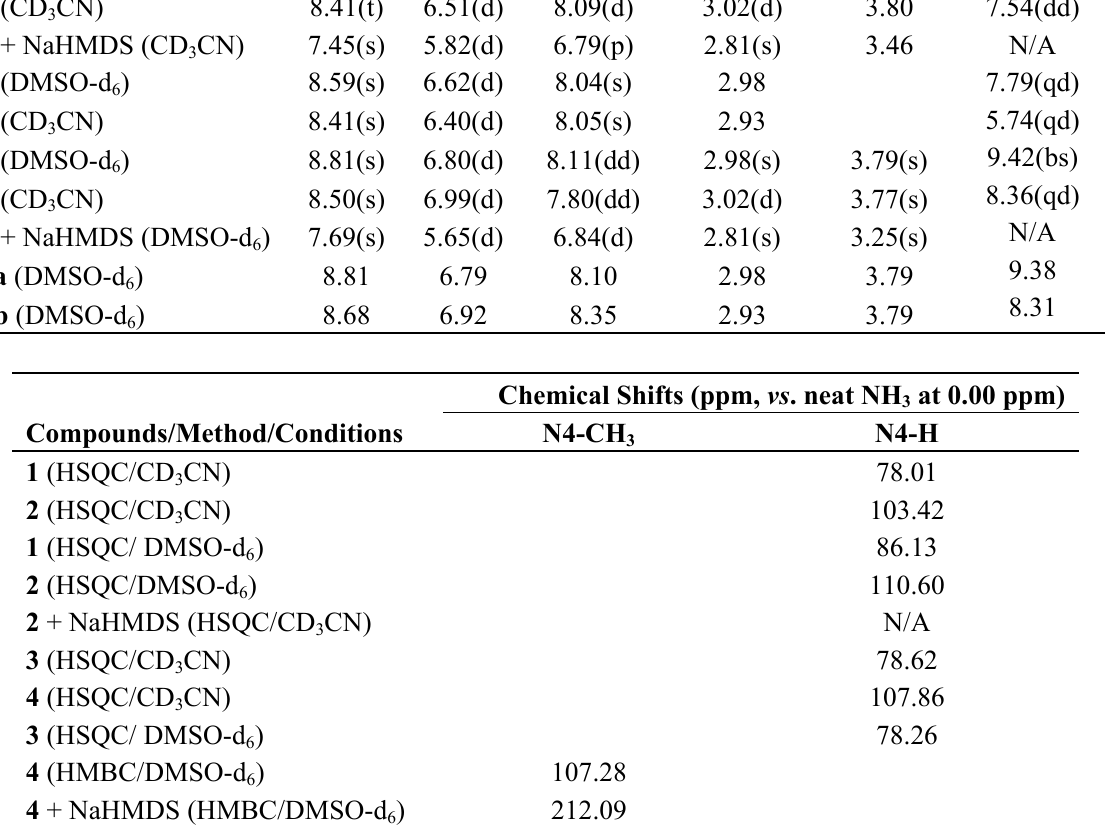
Table 2. 1 H (Top) and 15 N (Bottom) chemical shifts ( 45 ) of 4-aminopyrimidine ( 1 ),